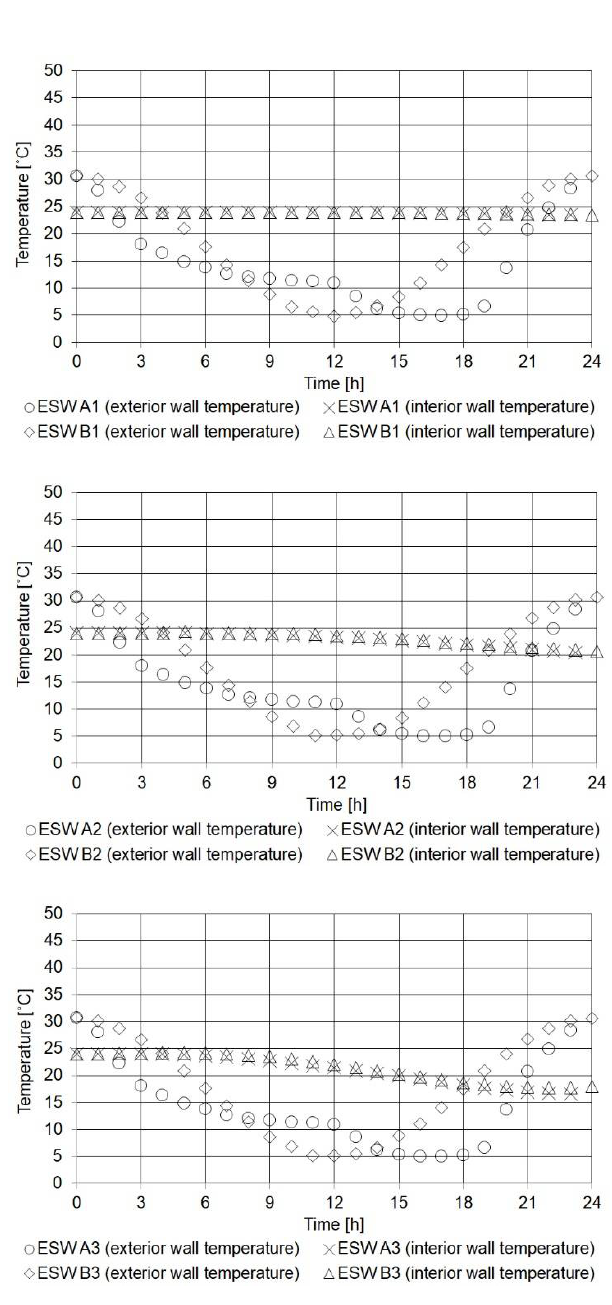
Figure 6. Simulation results for building wall models A and B for sunny winter conditions (ESW).